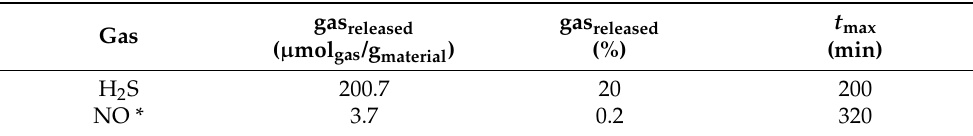
Figure 6. H 2 S release profile of the H 2 S-loaded i-POF material in aqueous solution using the DTNB method ( top ). NO release profiles in liquid phase from NO-loaded i-POF material using the oxyhemoglobin assay ( bottom ). Table 2. H 2 S and NO released by i-POF in aqueous solution at pH 7.2 at room temperature determined using the DTNB method and oxyhemoglobin assay.